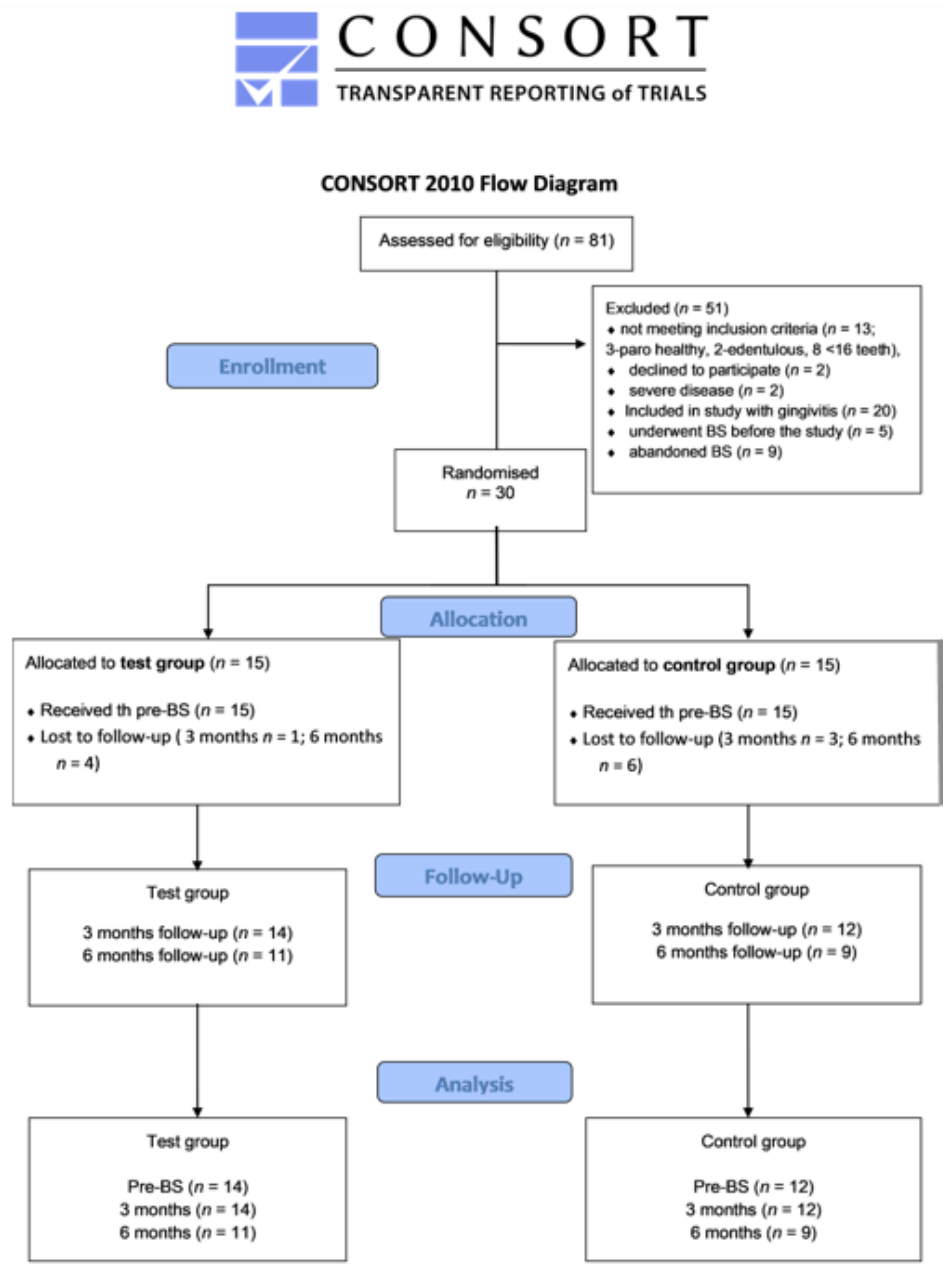
Figure 1. Flow diagram of patient recruitment and inclusion process. Pre-BS, baseline measure- ments.